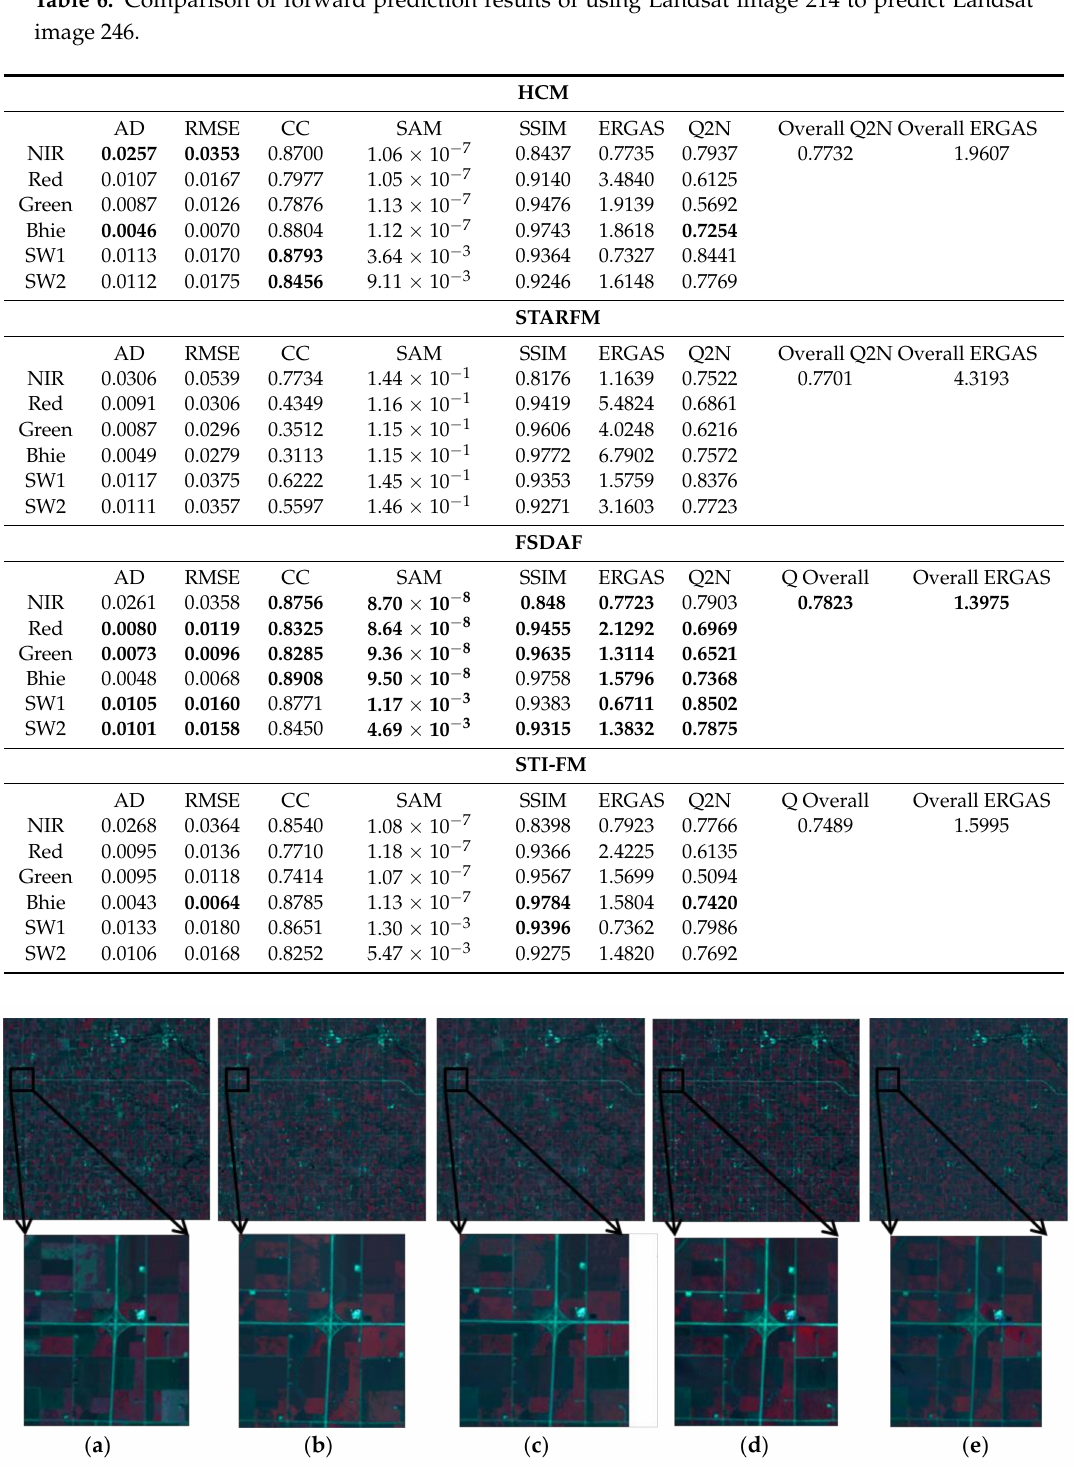
Figure 8. Comparison of forward prediction results of using Landsat image 214 to predict Landsat image 246. ( a ) Actual image; ( b ) STARFM; ( c ) FSDAF; ( d ) STI-FM; and, ( e )